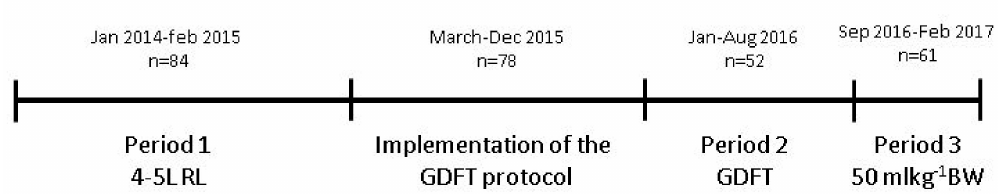
Figure 1. Timeline of various intraoperative fluid protocols in recipients. L: liters; RL: Ringers’ lactate; GDFT: goal directed fluid therapy, BW: body